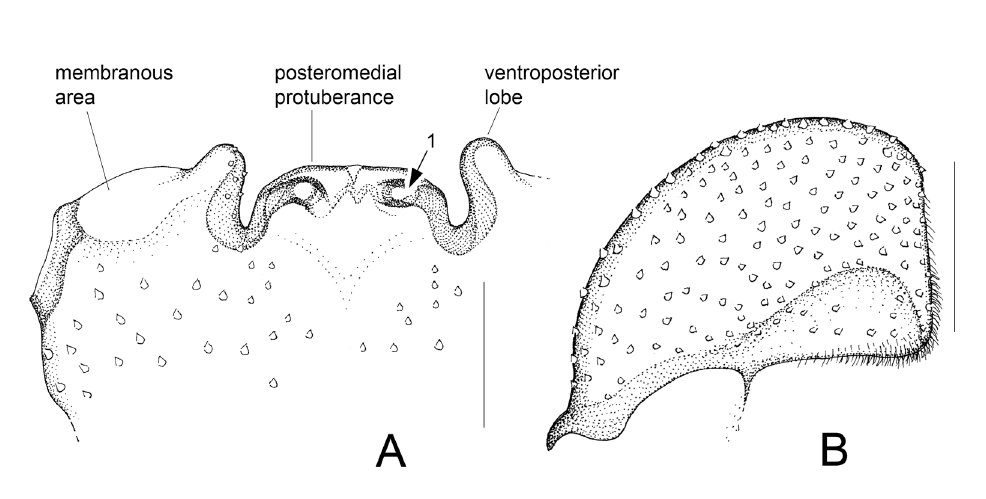
Fig. 2. Glemparon sagittifer Jaschhof, 2013, ♂. A . Gonocoxites, ventroposterior. B . Gonostylus, ventral. Scale bars = 0.05 mm. The numbered arrow indicates a diagnostic character (see